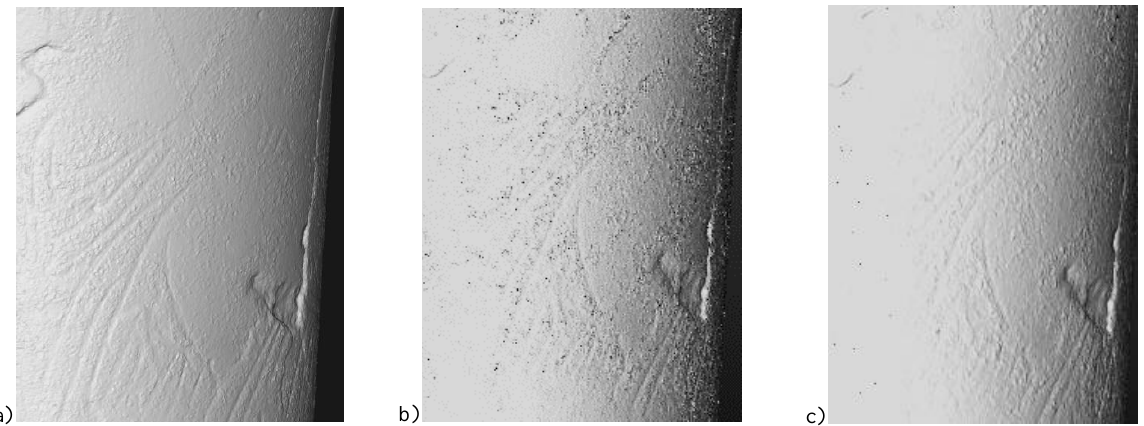
Figure 4. Shaded detailed view of the 3D scanner mesh model (a) and photogrammetric dense point cloud: after the automatic dense image matching procedure (b) and after a semi-automatic editing approach to remove the highest-frequency noise in the area with low signal-to-noise ratio (mainly dark colour) areas.